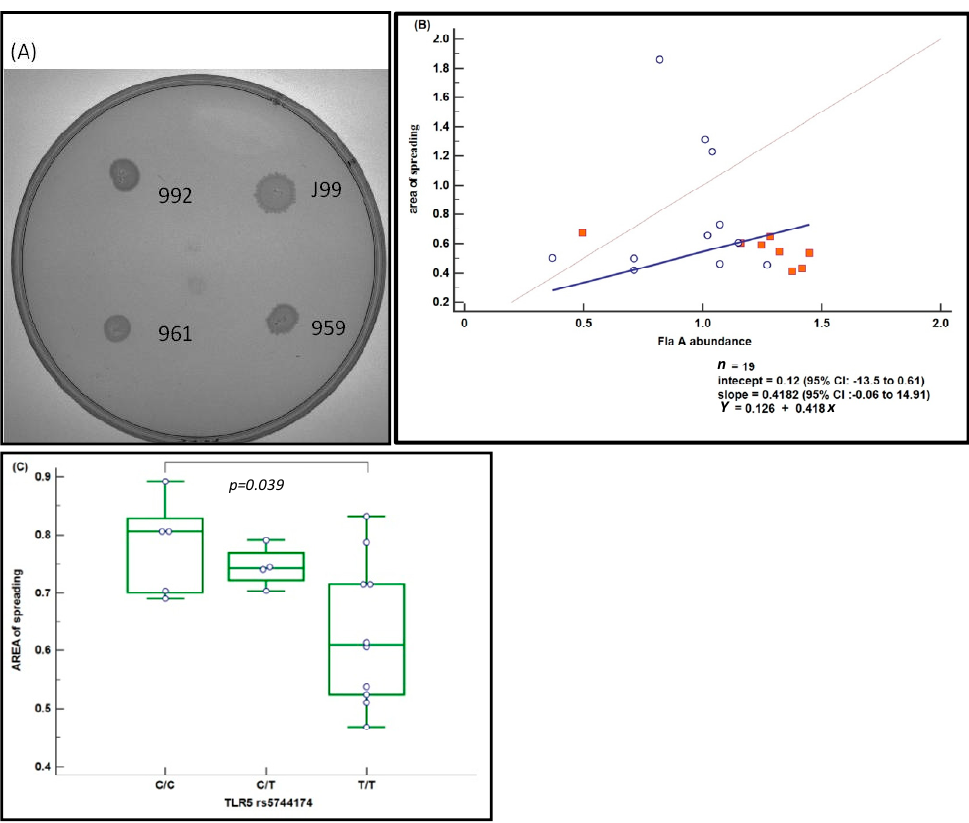
Figure 4. Motility of H. pylori ( A ) Bacteria were plated in soft agar and photographed after incubation for 7 days at the same multiplicity. Control: HPJ99, motile H. pylori strain J99 (ATCC700824) from patient with duodenal ulcer ( B ) Passing badlock regression plots for area of spreading surrounding each H. pylory colony (mm, mean of triplicate experiment) versus FlaA abundance. H. pylori were recovered from 11 AAG (hollow circle) and from 8 GC patients (filled squares). Dashed line represents the optimal regression line; solid line represents the best fit by linear regression including AAG and GC ( n = 19) cases ( Y = 0.12 + 0.42 x ). ( C ) Analysis of area of spreading versus TLR5 genotype corrected by FlaA abundance covariate. FlaA abundance